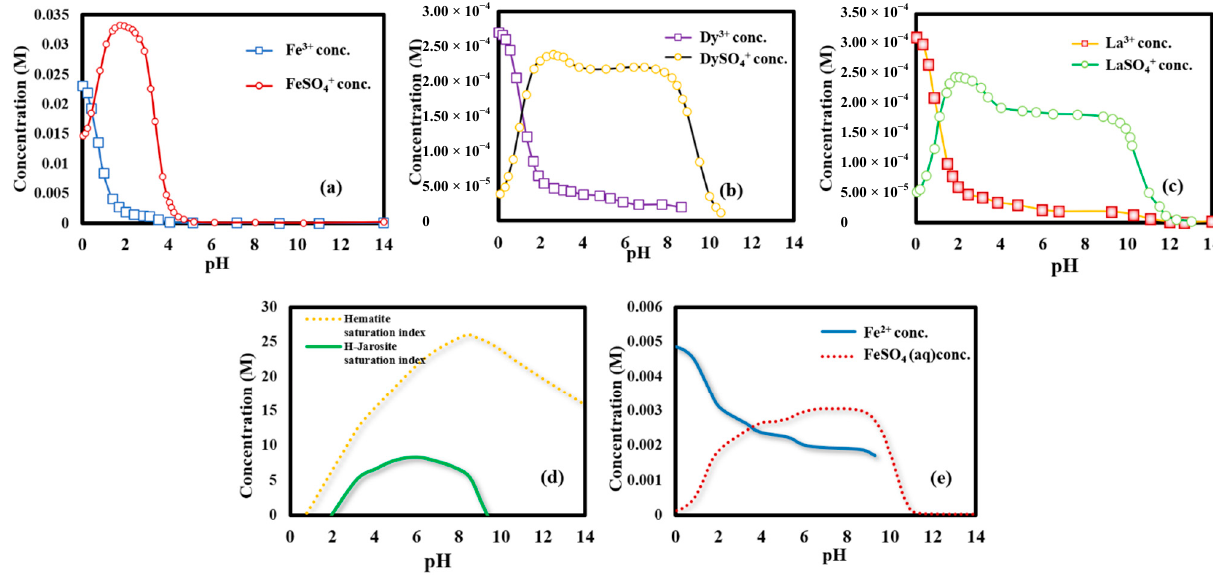
Figure 5. Comparison of Visual Minteq 3.1 calculated species concentrations as a function of pH for a system containing 10 g/L of ferric sulfate heptahydrate and 50 ppm of lanthanum and 50 ppm of dysprosium: ( a ) Fe 3+ and FeSO 4+ , ( b ) Dy 3+ and DySO 4+ , ( c ) Dy 3+ and DySO 4+ , ( d ) hematite and jarosite saturation index, ( e ) Fe 2+ and FeSO 4 when 0.005 M Fe 2+ presents.